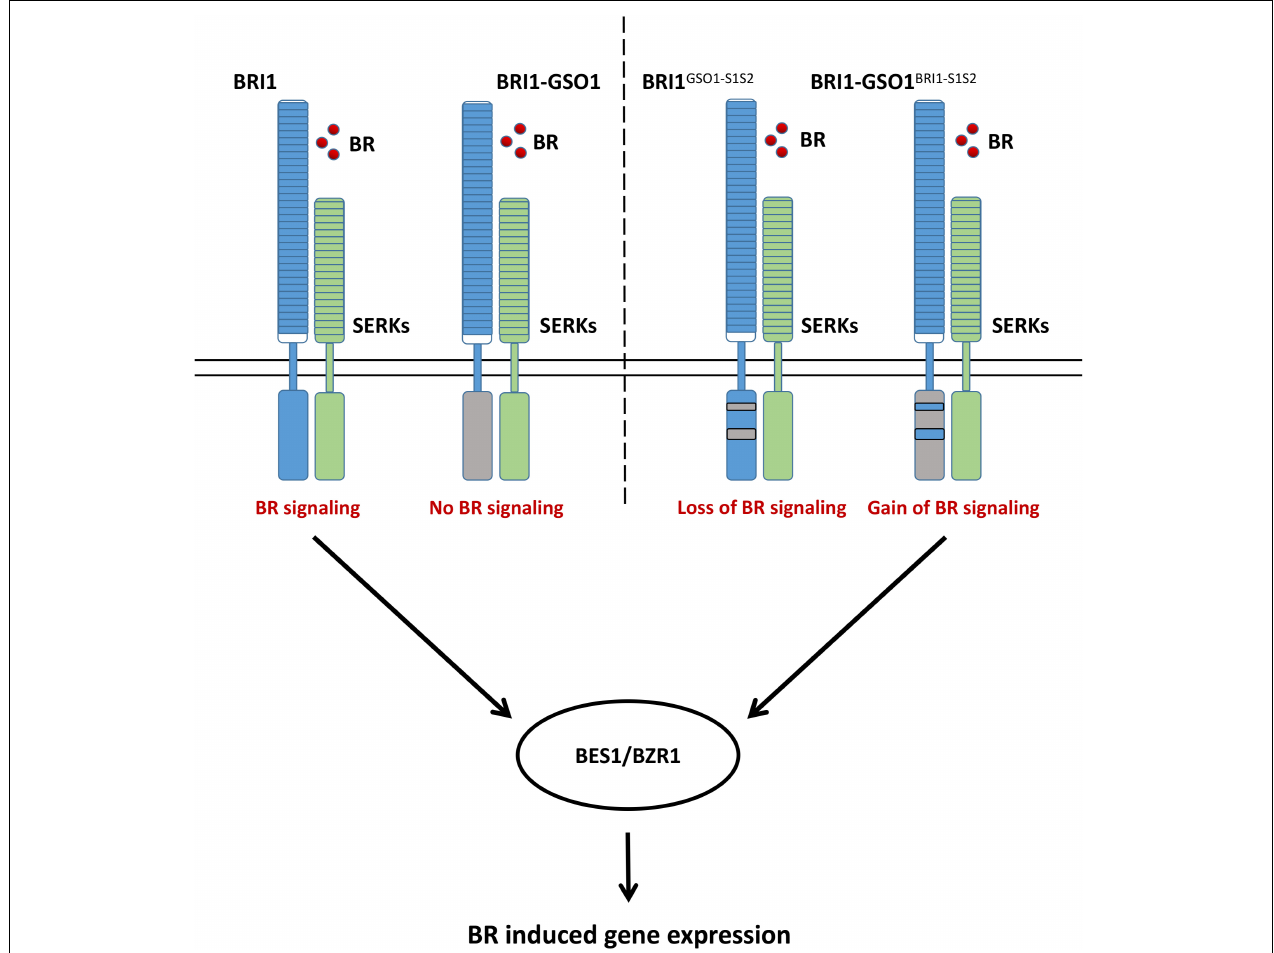
FIGURE 6 | A proposed model illustrating how BRI1 specifies its function from GSO1, which leads to the control of distinct biological function and how a domain swap from BRI1 into chimeric BRI1-GSO1 can completely restore the BR signaling